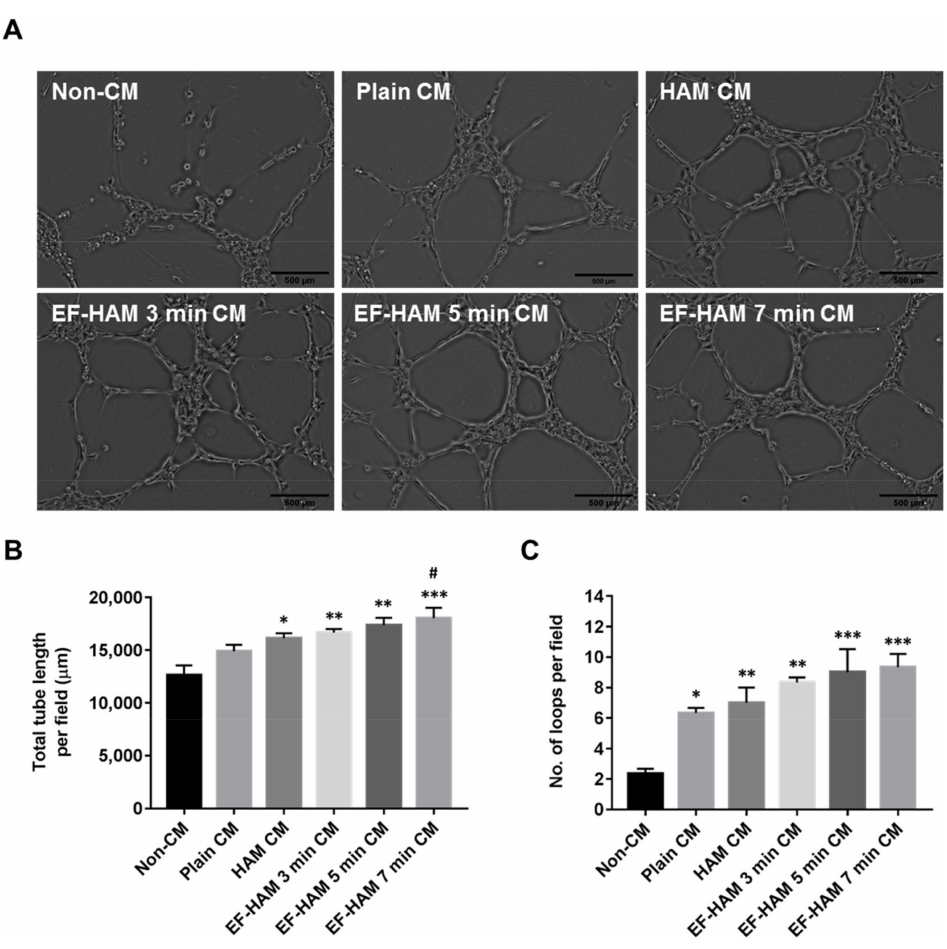
Figure 6. EF-HAM 7 min CM induced longer tube formation in HUVECs than plain CM. ( A ) Forma- tion of capillary-like structures by HUVECs cultured in the presence of CM from different SkM-seeded scaffolds on Matrigel. ( B ) Total tube length and ( C ) number of loops per field were quantified to evaluate the proangiogenic effects of CM on endothelial tube formation. The values are represented as mean ± SEM (* p < 0.05, ** p < 0.01, or *** p < 0.001, compared with non-CM control; # p < 0.05, compared with plain CM; One-way ANOVA). Scale bar: 500 µ